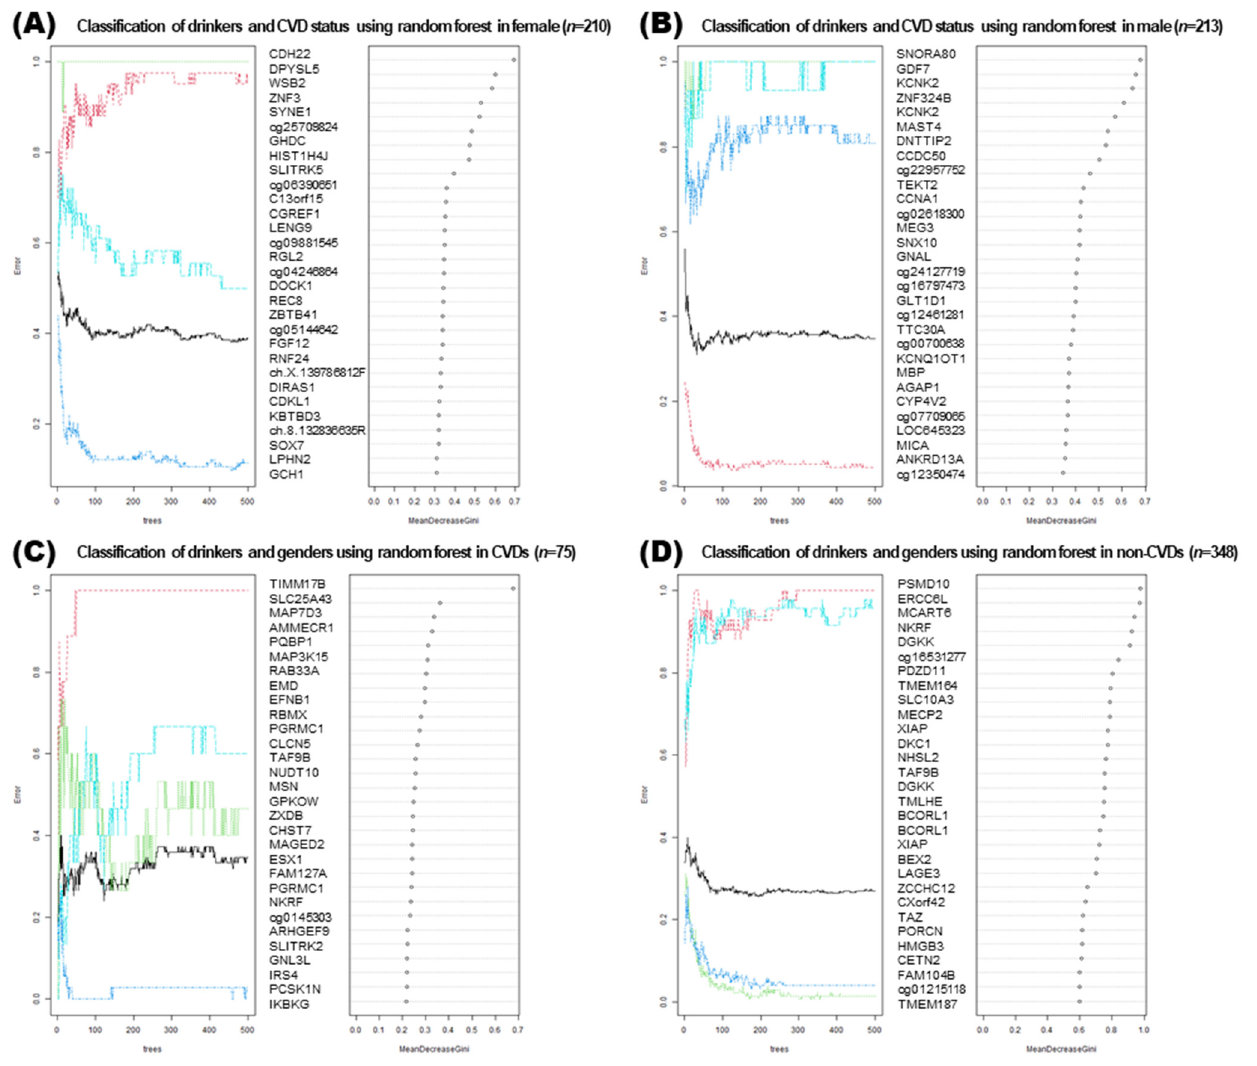
Figure 7. Random forest analysis results classifying the four groups from 423 samples. Each of the four random forest outputs was provided as an error plot and variable importance plot. Three conditions (sex, drinking, and chronic cardiovascular diseases; CVDs) were considered as criteria for classification. Subjects afflicted with at least one of the diseases, including myocardial infarction, coronary artery, hyperlipidemia, and hypertension, were included as subjects with CVDs. Variable importance plot of the random forest analysis resulted from the integration of a large number of models built by classification of each of the four groups. The variables are ordered top-to-bottom as most-to-least important in classifying the four groups. The ranked list of variables indicates the im- portance of each variable in classifying the data. The figure shows the top 30 variables important in the classification of the four groups. Four groups were divided based on the drinking and CVD status ( A ) from 210 female samples and ( B ) from 213 male samples. Similarly, four groups each were divided based on the drinking status and sex ( C ) from 75 CVD samples and ( D ) from 348 non-CVD samples. 4. Discussion 4.1. DNA Methylation in Male vs. Female EWAS are a powerful way to understand the relationships between epigenetic vari- ation and human diseases. In this study, we investigated the epigenetic differences asso- ciated with drinking status, and provided DMRs related to alcoholism in two sexes [29,30]. Differential methylation patterns of the two X chromosomes lead to distinction between